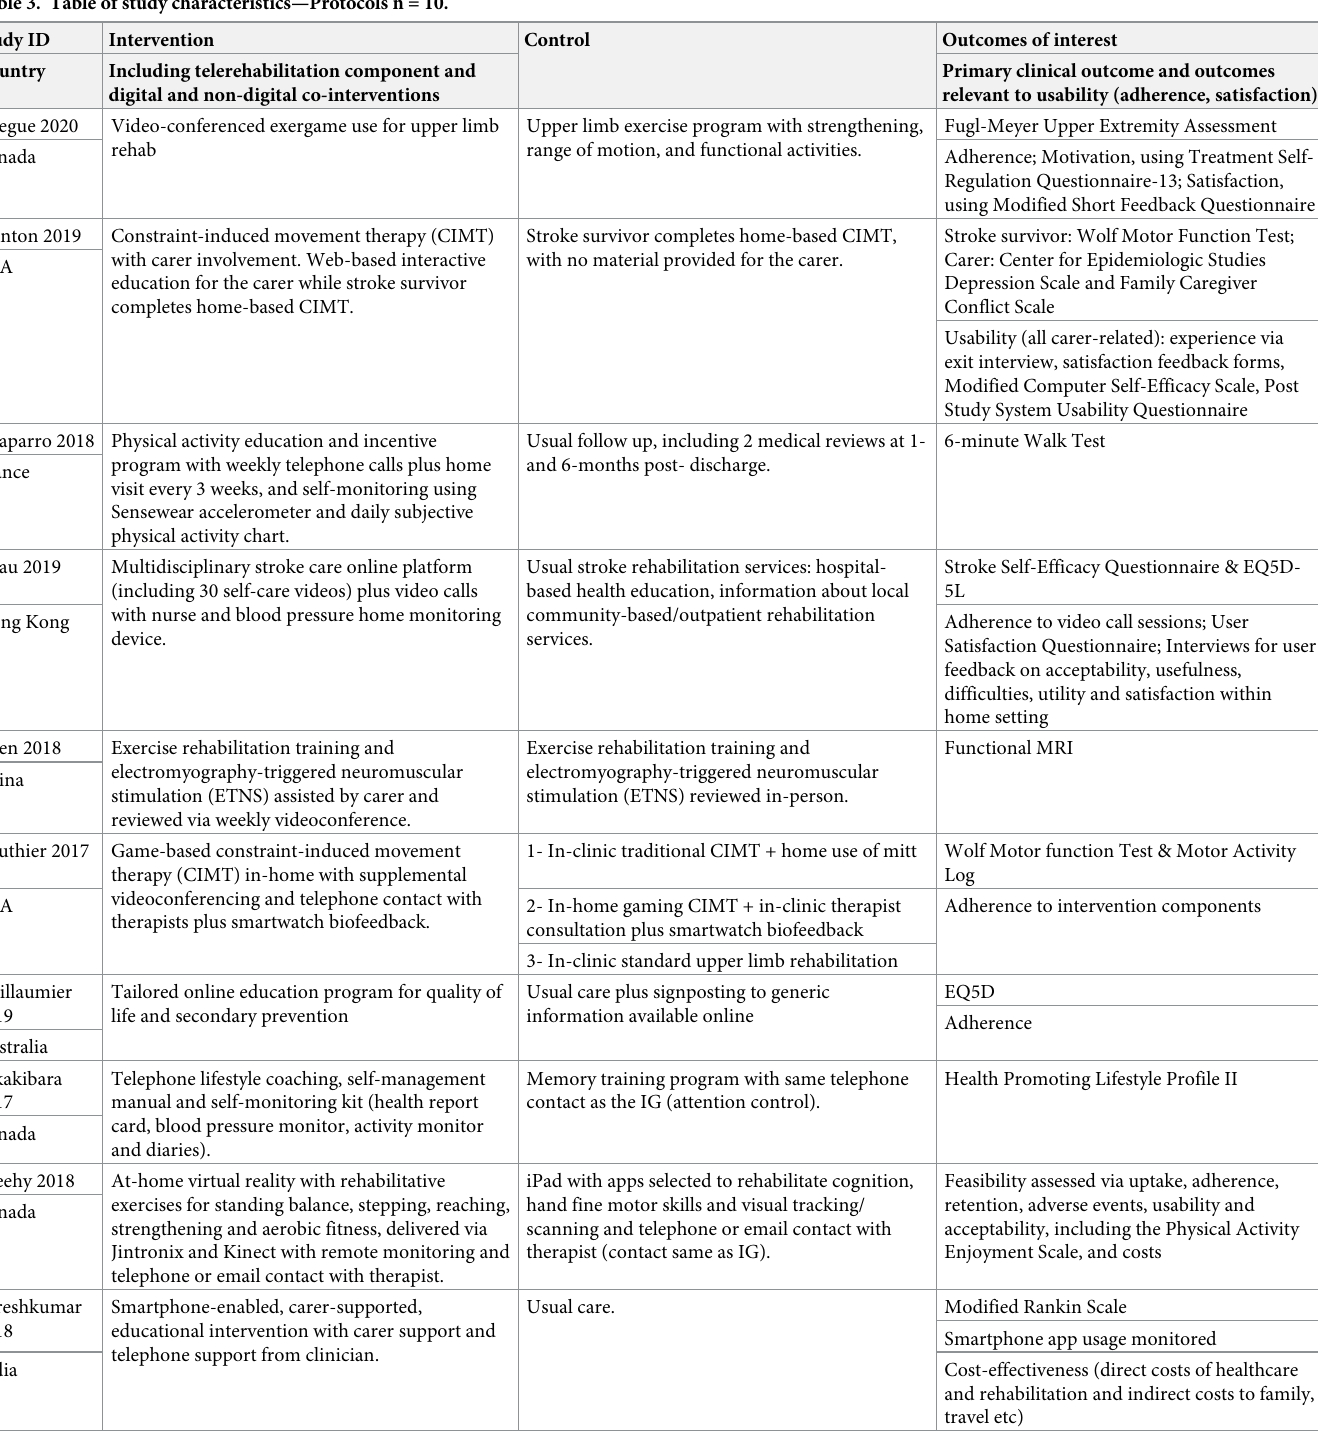
Table 3. Table of study characteristics—Protocols n =